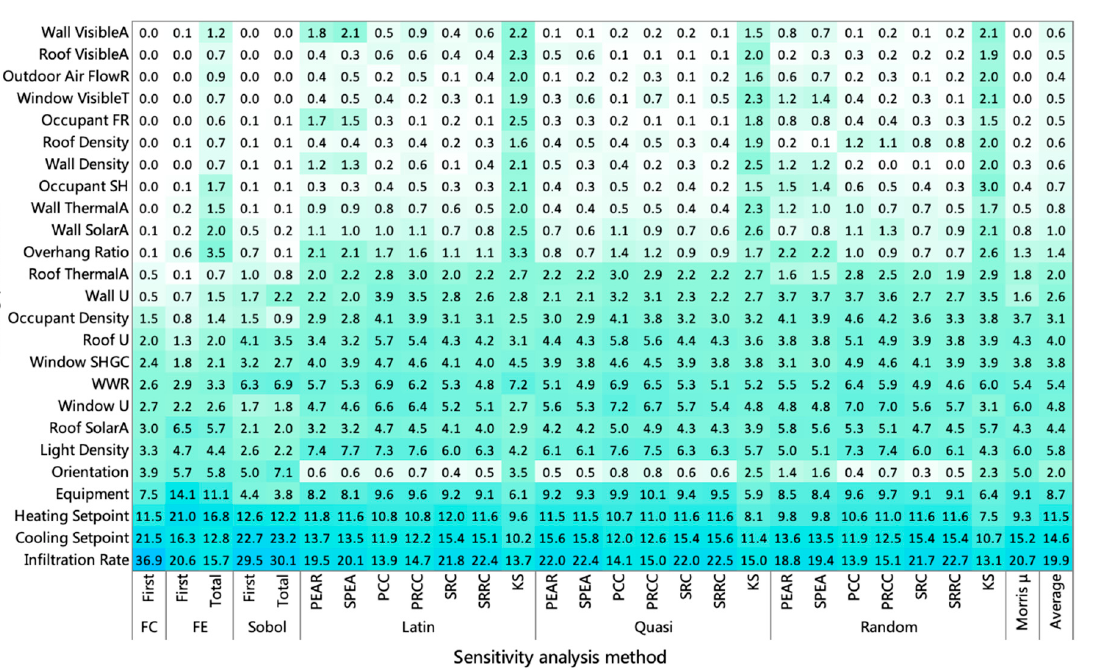
Figure 12. PI of input parameters in different sampling and SA methods.